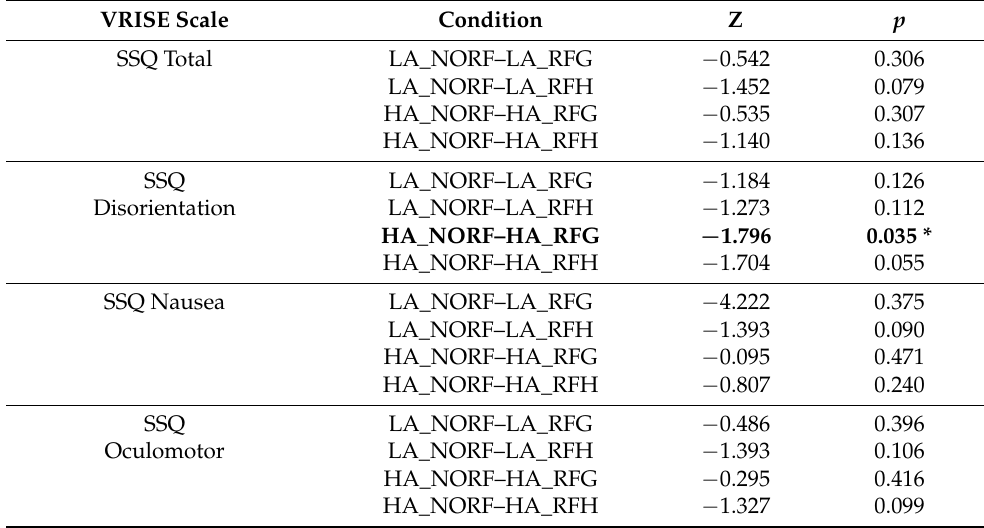
Table 14. Wilcoxon signed-rank test for the SSQ scores between the no rest-frame and rest-frames conditions for users experienced with VR